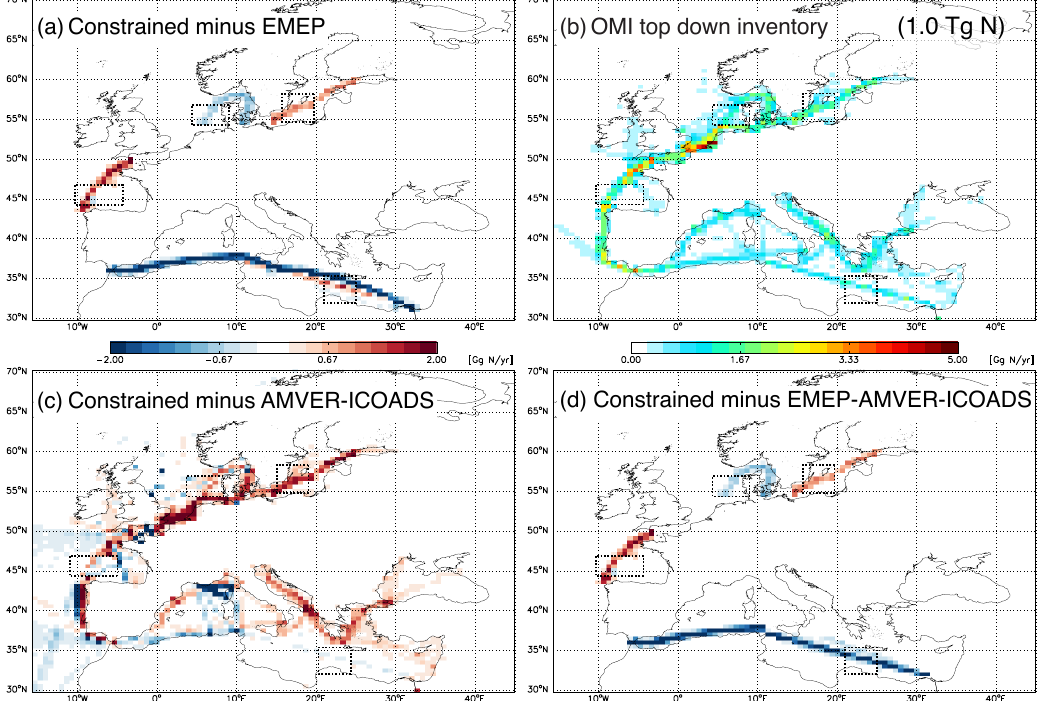
Fig. 9. Absolute difference in GgNyr − 1 between the OMI top-down ship NO x inventory for 2005 (b) and the EMEP-AMVER-ICOADS inventory (d) , indicating the ship tracks that were constrained in this study. Differences between the new top-down inventory and the (global) AMVER-ICOADS inventory (c) show good agreement in the Mediterranean Sea, but also show the lack of domestic ship traffic emissions in coastal waters. Comparison with the original EMEP inventory (a) shows the mislocated ship emissions in the Mediterranean Sea, as was discussed in Sect. 3.1. Dashed boxes indicate the ship track areas that were used to calculate constraints in this